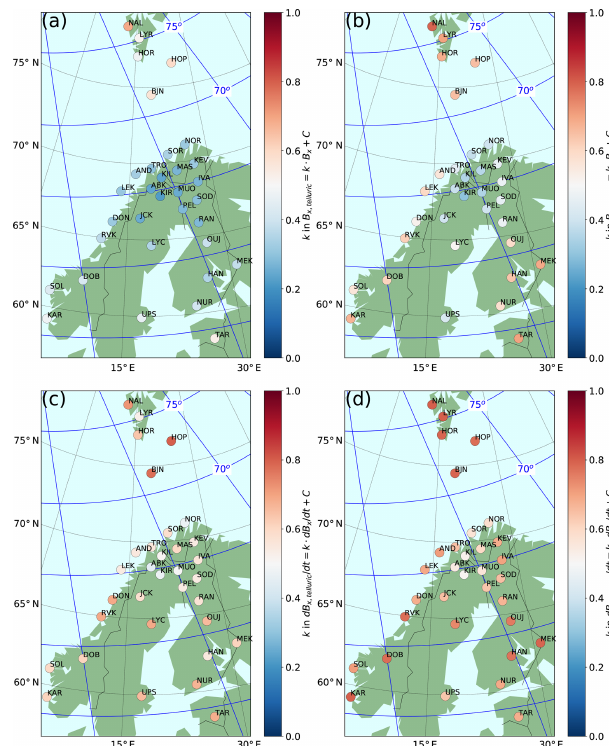
Figure 7. Slope, k , of the fitted line B x, telluric = k · B x + const . , with d H/ d t > 1nTs − 1 for IMAGE stations with sufficient amounts of good data available during 1994–2018 (a) . The same slopes for B y (b) , d B x / d t (c) , and d B y / d t (d) . Magnetic coordinates are in- dicated by the blue grid. The separation of the arbitrarily placed constant longitude lines corresponds to 1h in